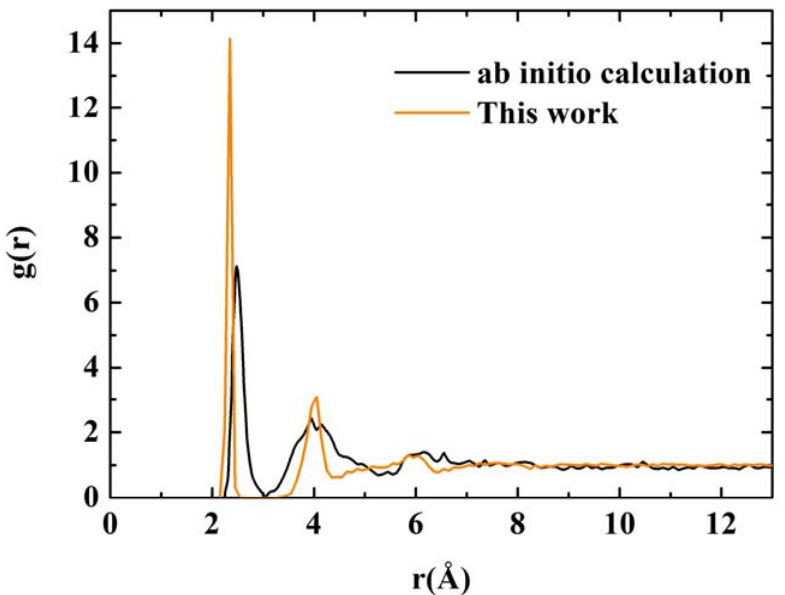
Figure 11. RDFs for nanoporous silicon. The black line is the RDF obtained by Valladares et al . [23] by means of an ab initio calculation on a 216 atom supercell (see Figure 8). The orange line was obtained using the Tersoff interatomic potential and a 1,000 atom periodic supercell.